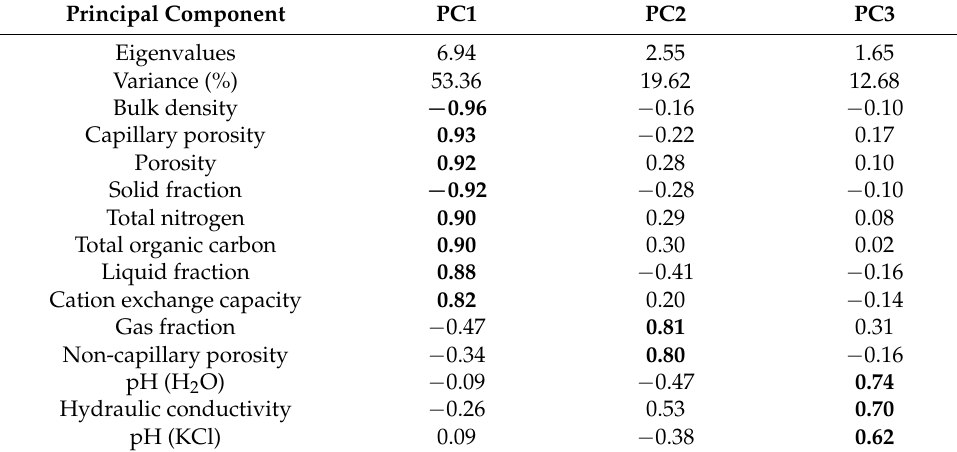
Table 5. Principal component analysis of soil quality